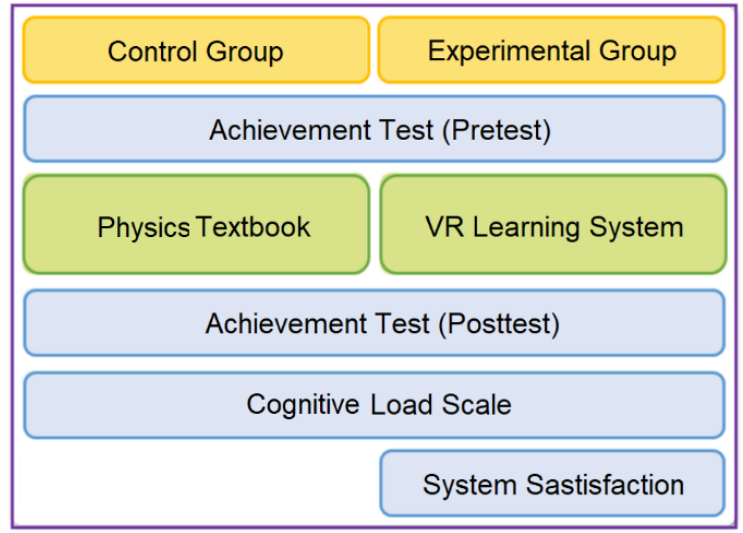
Figure 13. Flowchart of the teaching experiment in this study.